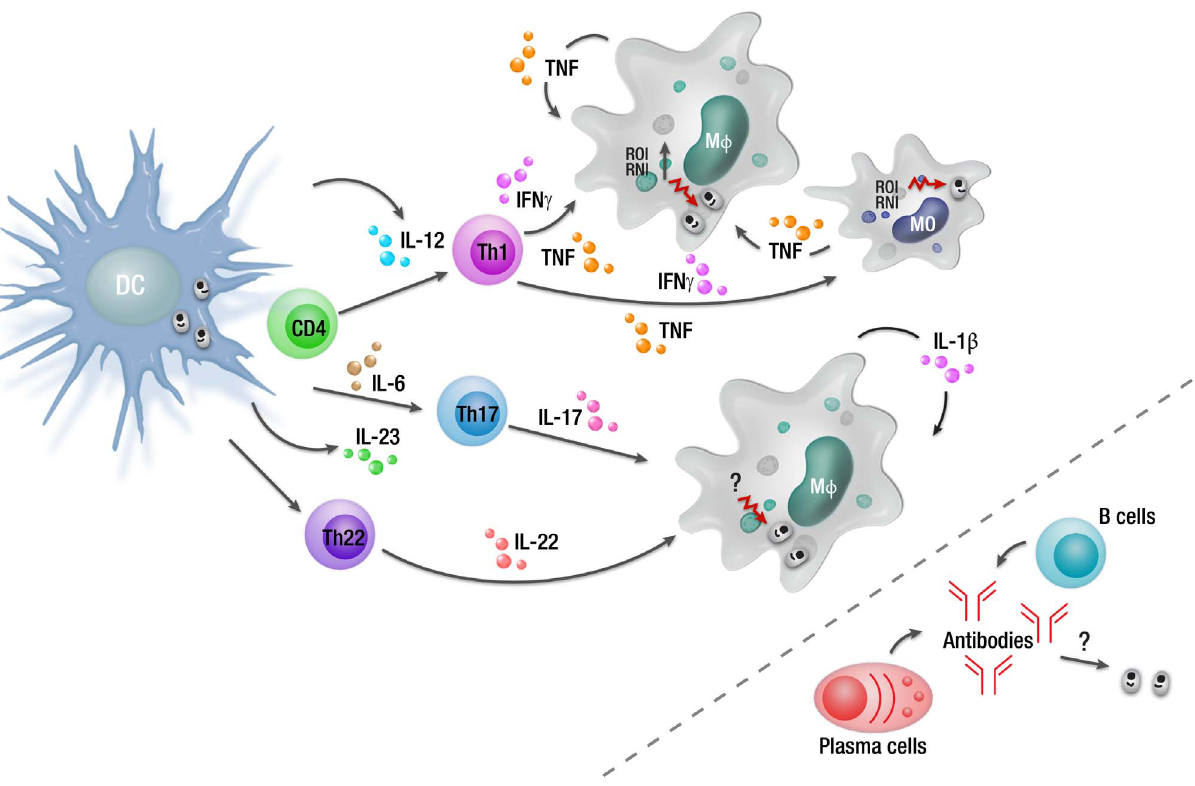
Figure 1. Overview of cellular responses during an asymptomatic L.donovani infection. Infected macrophages can produce TNF and IL-1 b in response to L. donovani infection as part of the innate immune response. However, DC IL-12 production in response to L. donovani infection is required to drive the differentiation of antigen-specific CD4 + T cells into IFN c - and TNF-producing Th1 cells. These cells can activate infected macrophages and monocytes to produce ROI and RNI that kill intracellular parasites. There are also reports in humans that Th17 and Th22 cells develop in asymptomatic, infected individuals, possibly driven by IL-23 and IL-6. However, the antiparasitic mechanism mediated by these CD4 + T cell subsets following L. donovani infection remains unknown. Although parasite-specific antibodies are readily detected in asymptomatic individuals, their role, if any, in control of infection and protection against reinfection is unknown. Abbreviations: MO, monocyte; M w , macrophage.